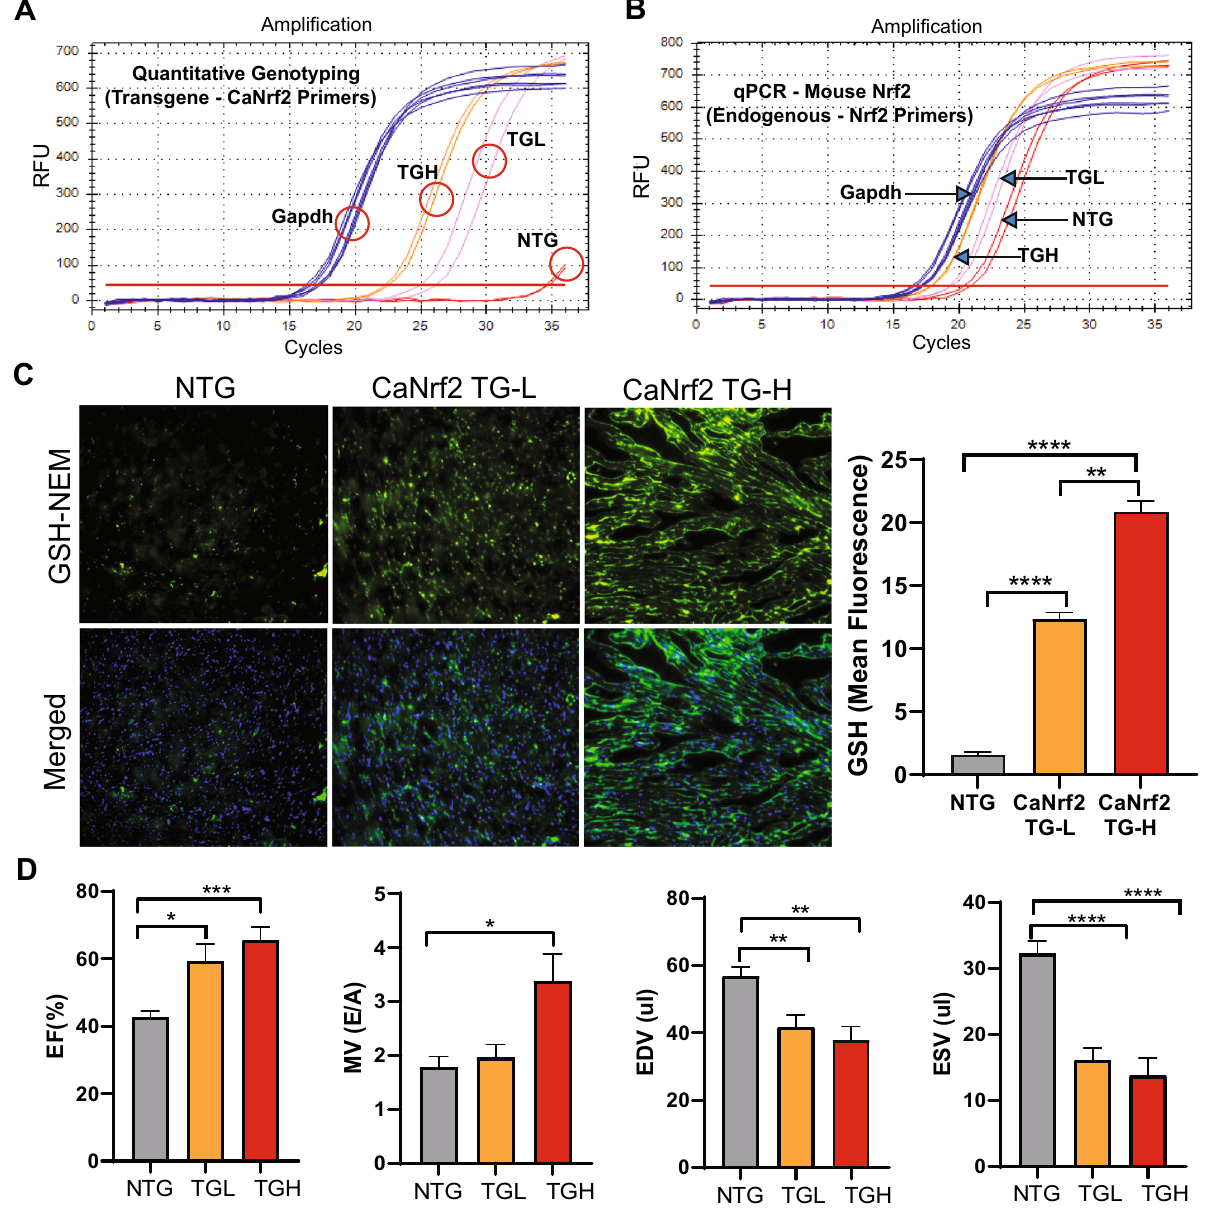
Figure 1. Differential expression of transgene, myocardial glutathione, structural and functional remodeling in caNrf2 mice. Real-time qPCR-based quantitation of transgene (CaNrf2) expression in transgenic low (TgL) high (TgH) and non-transgenic (NTg) hearts using ( A ) genotyping primers (recognizes caNrf2) and ( B ) endogenous Nrf2 primers vs Gapdh (n = 4/group). ( C ) Representative immunofluorescent (IF) images and quantification of N-Ethylmaleimide-Glutathione adducts (green) and DAPI (blue) in heart sections of NTg, TgL and TgH mice (n = 3/group). ( D ) Two-dimensional trans-thoracic echocardiography (para-sternal long axis strain analysis) was used to estimate ejection fraction (EF%), mitral valve (early, E to late, A ratio) filling, end diastolic volume (EDV) and systolic volume (ESV) (n =